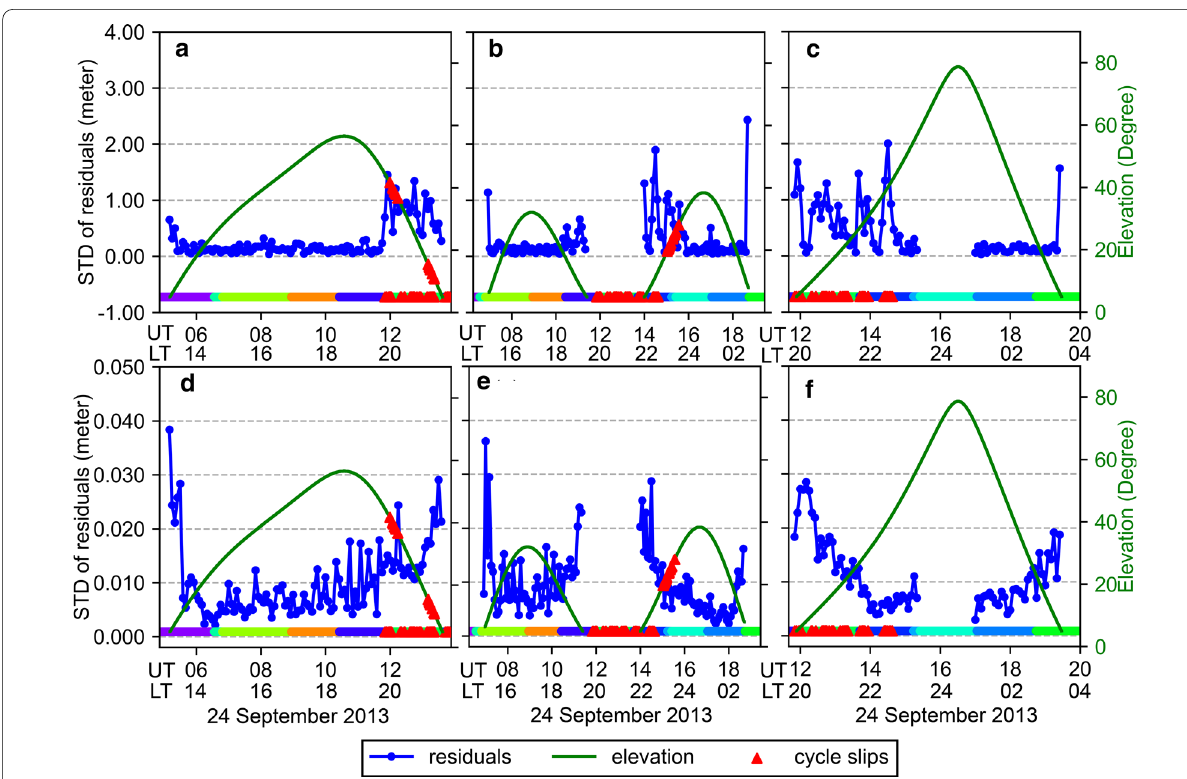
Fig. 16 STD of residuals of ionosphere-free measurements on pseudorange and carrier phase GPS PRN 2 ( a , d ), GPS PRN 12 ( b , e ), and GPS PRN 18 ( c , f ) for the baseline HKPC–HKOH along with the elevation and cycle slip information on 24 September 2013. The blue line with circles denotes the STD of residuals for every 5 min; the green line denotes the elevation angle; the red triangles on green lines represent cycle slips of GPS PRN 2, 12, and 18 satellites. The thick straight line with colors represents reference satellites; the red triangles on the thick straight lines represent cycle slips of the reference satellites